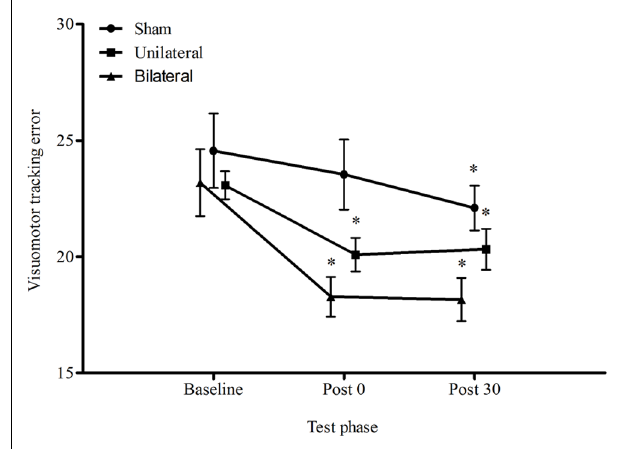
FIGURE 2 |Average ± SEM tracking error (%) for all conditions across all time points . ∗ p < 0.05 compared to baseline. No significant condition by time interaction p > 0.05.